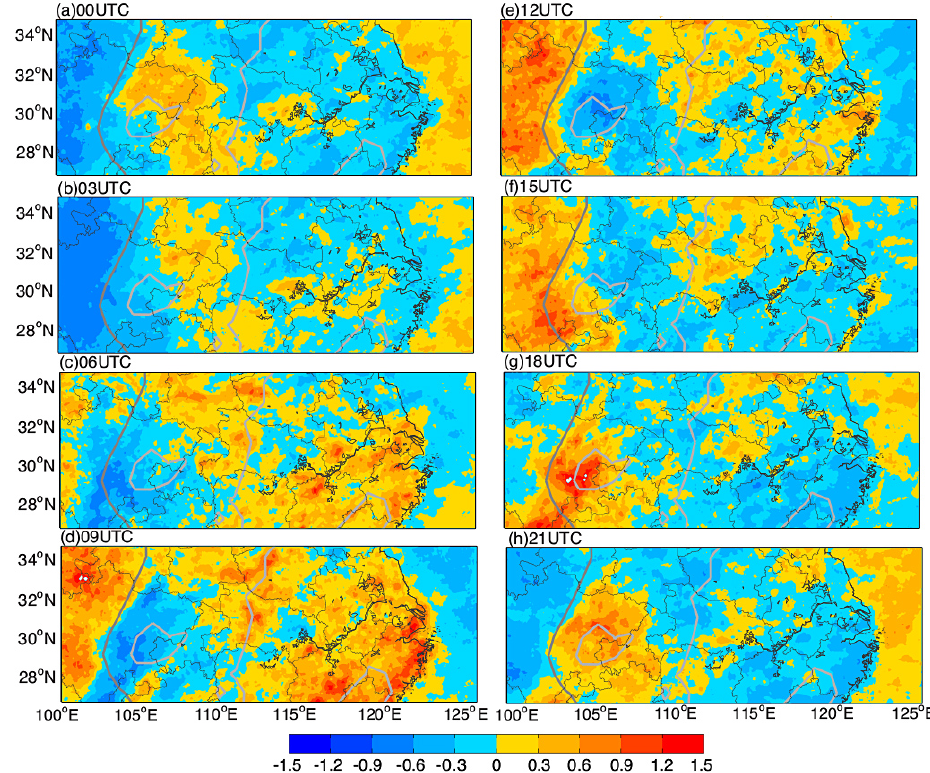
Figure 3. Map distributions of the normalized hourly mean precipitation valid at (a) 00:00, (b) 03:00, (c) 06:00, (d) 09:00, (e) 12:00, (f) 15:00, (g) 18:00 and (h) 21:00UTC averaged over the warm season in East Asia. The darker gray line represents the terrain elevation of 5000m and the lighter one of